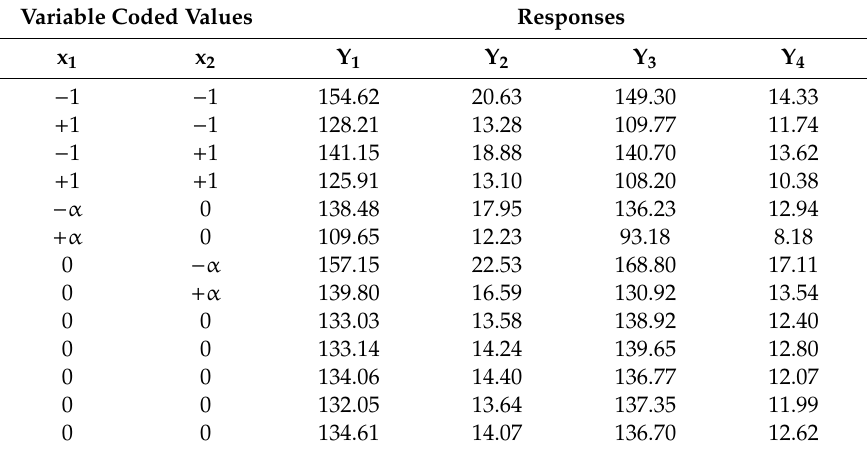
Table 2. Experimental results of the central composite rotatable design (CCRD) for the optimization of the variables involved (x 1 and x 2 ) in the ultrasound-assisted extraction of antioxidants from ginger for the four responses, Y 1 , Y 2 , Y 3 , and Y 4 .